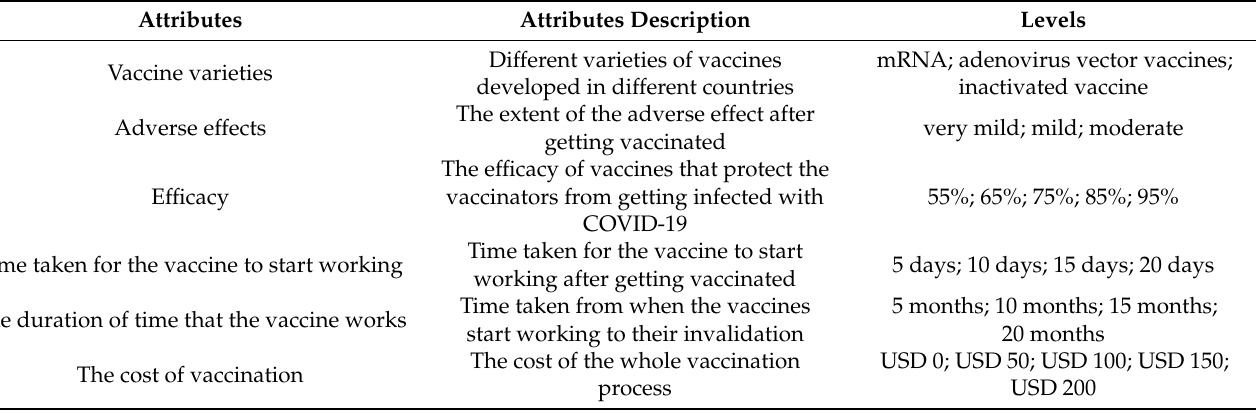
Table 1. The attributes and levels of vaccine acceptance and